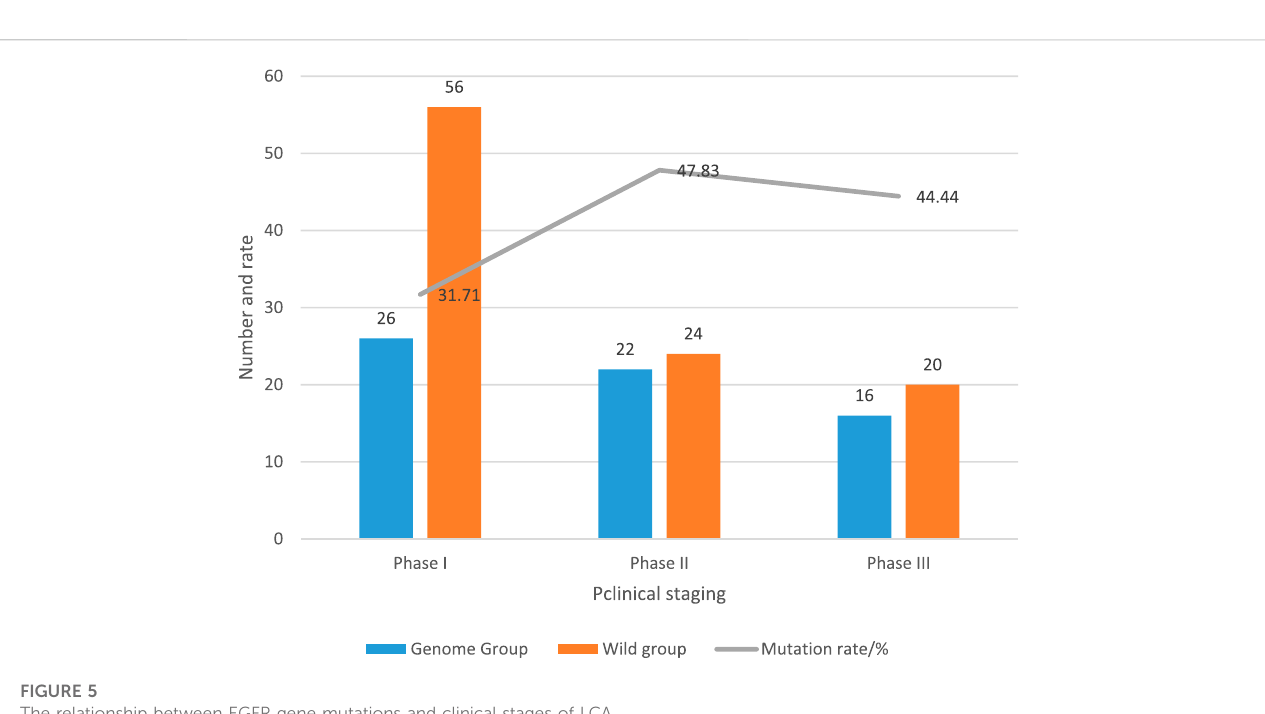
Thoracic thickening-